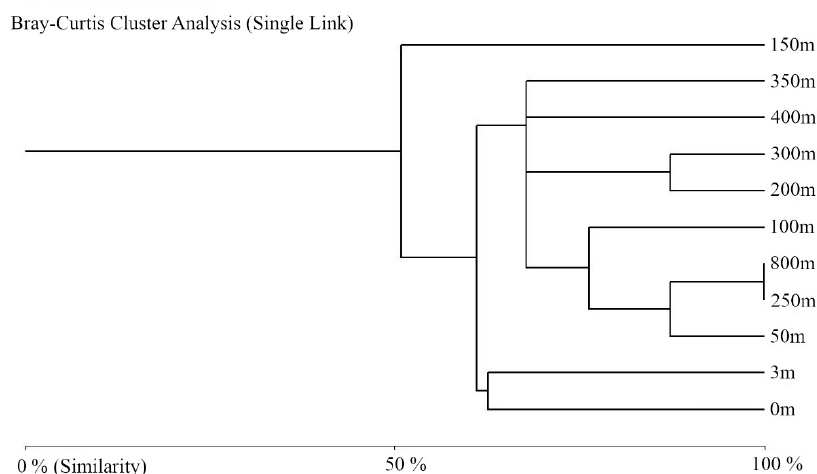
Figure 3. Dendrogram of the Bray–Curtis similarity measures for the filamentous fungi recovered from the Collins Glacier retreat-exposed soil samples. Table 2. Analysis of generalized linear models (GLM) between the cultivable fungus community and the environmental variables of the Collins Glacier (Fildes Peninsula, South Shetlands Archipelago, King George Island, Maritime Antarctica).